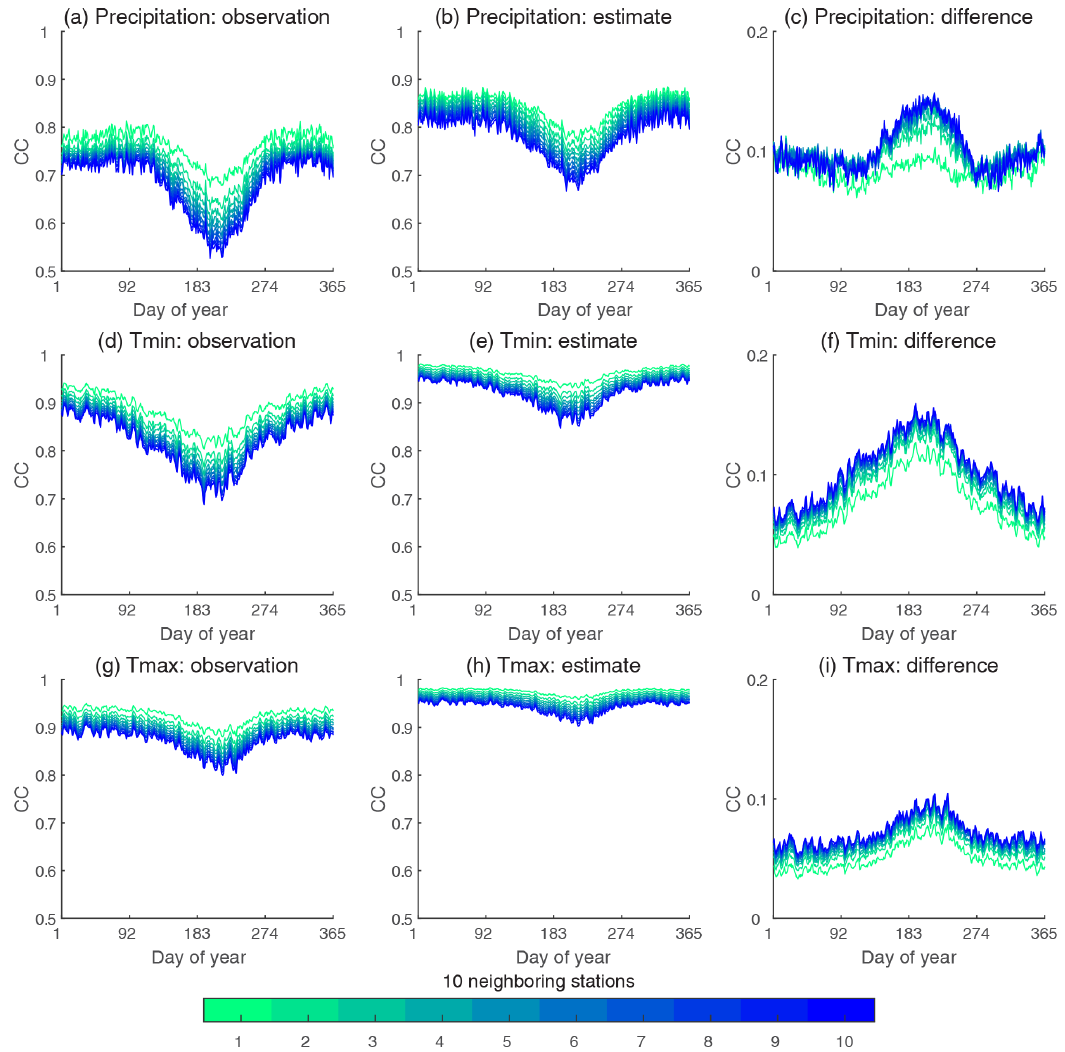
Figure 8. CC between target and neighboring stations for all DOY using station observations (the first column), SCDNA estimates (second column), and differences between SCDNA- and observation-based CCs (the third column). The CC is calculated for the observation period. For each target station, 10 neighboring stations are selected according to the correlation between time series from target and neighboring stations. Smaller numbers represent a higher correlation. For example, station 1 represents the neighbor with the highest CC in comparison to the target station. Each curve represents the median CC of all